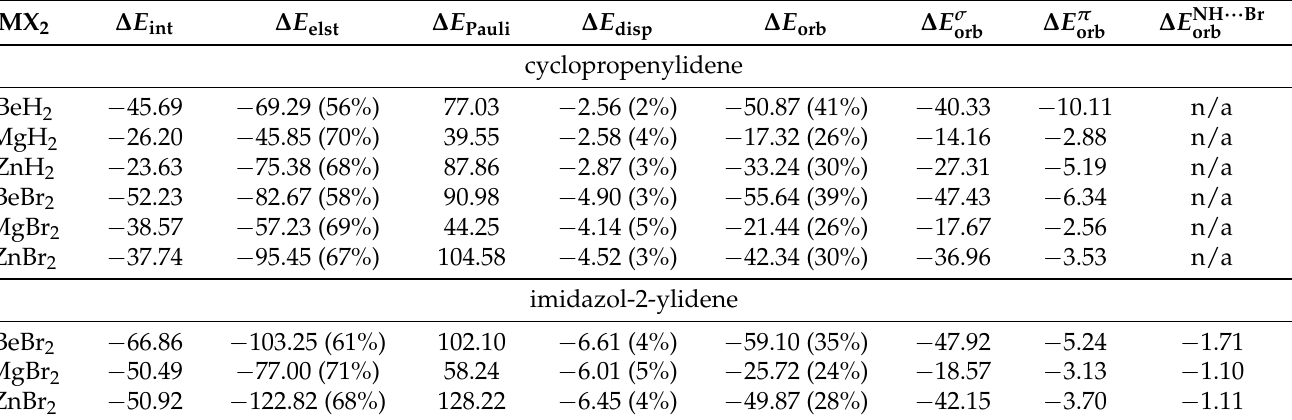
Table 4. The ETS-NOCV-based energy (in kcal/mol) contributions to carbene · · · MX 2